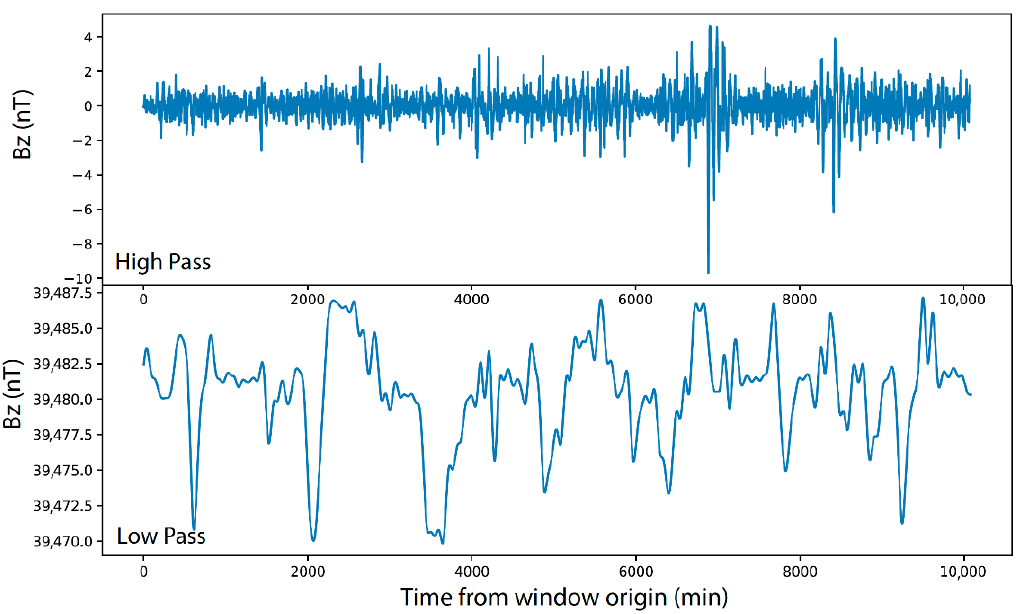
Figure 3. One-week-long vertical geomagnetic field amplitudes at the Duronia (DUR) observatory in Italy (Figure 4), filtered with high- and low-pass digital filters with a corner frequency of 0.02 Hz, applied twice (forward and backward) to preserve phase information.